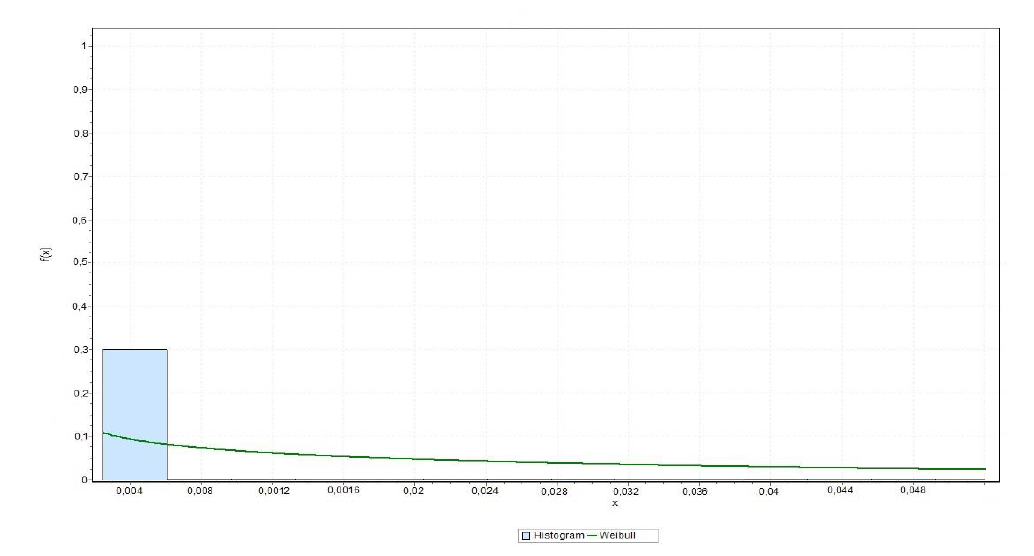
Figure 6. Weibull-distribution of time intervals between packages, the value of the parameters: α 1 =0.78, β 1